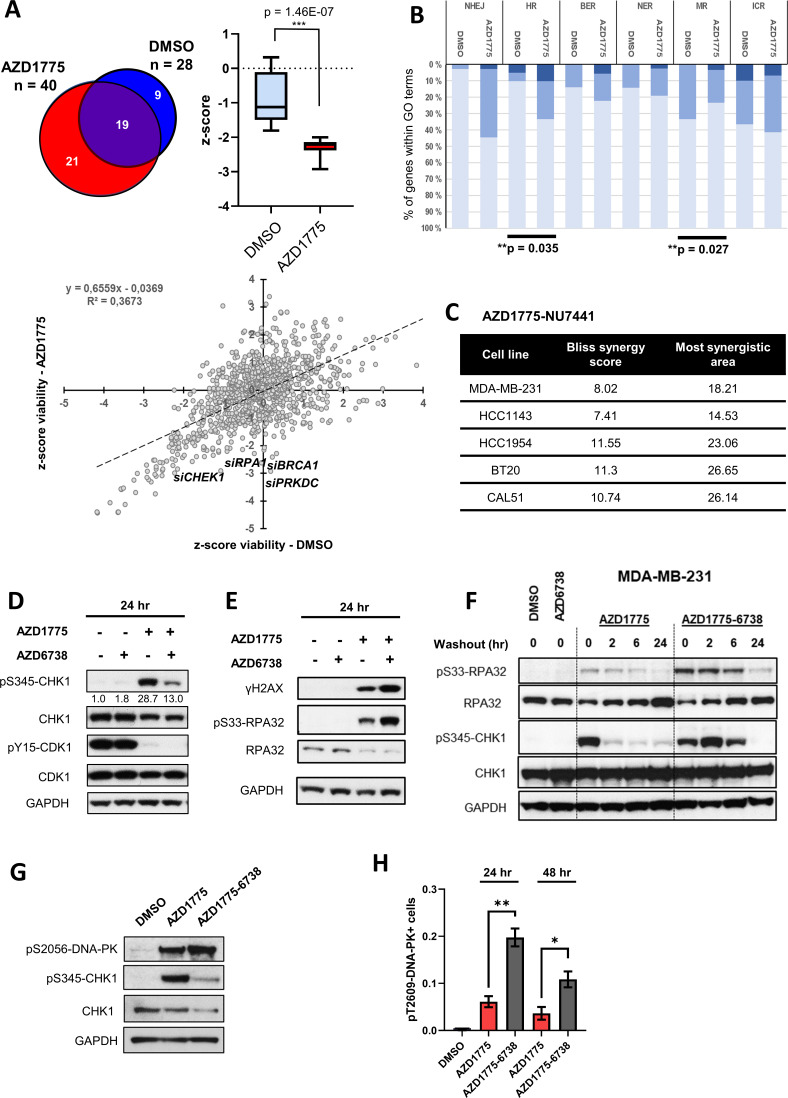
DNA-PK is phosphorylated in response to AZD1775 and preserves CHK1 phosphorylation independent of ATR.(A) MDA-MB-231 cells were transfected with a library of siRNAs targeting 300 DNA repair genes and analysed for siRNA hits (three siRNAs per gene) reducing viability in response to AZD1775 treatment by high-content image analysis. siRNAs targeting 28 genes resulted in significant loss of viability in control conditions compared to 40 genes in combination with AZD1775. 21 genes selectively reduced viability when combined with AZD1775 (p=1.46E-7) (Upper panel). Scatter plot visualisation of the viability z-score correlation of all siRNAs in the screen. Target genes (siRNAs) affecting MDA-MB-231 cell viability from the DDR siRNA library in response to 72 hr treatment of AZD1775 are marked in the plot (Lower panel). (B) Grouping of different DNA repair pathway-associated genes from high-content siRNA screen based on gene ontologies. Knockdown of homologous recombination (HR) genes associates with increased sensitivity to AZD1775 (p=0.035). Bars are coloured according to z-score. z-score < −2 (dark), z-score < −1 (medium) and z-score - n.s. (light). (C) BLBC cell lines were treated with NU7441 and AZD1775 at different concentrations for three days. Drug synergy scores (Bliss model) calculated from dose-response matrices are shown as indicated. (D) MDA-MB-231 cells were treated for 24 hr with the indicated drugs or DMSO control as specified. Whole cell lysates were collected, and expression and phosphorylation of CHK1 and CDK1 was analysed by immunoblotting with the specified antibodies. Expression of phosphorylated CHK1 was quantified by normalizing band density to total CHK1 band density. GAPDH level was used as loading control. (E) MDA-MB-231 cells were treated as in D and protein expression and phosphorylation analysed with the specified antibodies, as depicted. (F) MDA-MB-231 cells were treated as in D and harvested or allowed to recover in the absence of the compounds for 2, 6 or 24 hr before harvesting. Total cell lysates were immunoblotted with the indicated antibodies. (G) MDA-MB-231 cells treated for 24 hr with the indicated drugs and phosphorylation of DNA-PK (pS2056) and CHK1 (pS345) was assessed by immunoblotting. GAPDH level was used as loading control. (H) MDA-MB-231 cells were treated with the indicated drugs for 24 or 48 hr and phosphorylation of DNA-PK (pT2609) was analysed by high-content immunofluorescence microscopy. The proportion of pT2609-DNAPK-labelled cells represents mean of three biological replicates ± SEM. * and ** indicate p=0.029 and p=0.0036 respectively, as assessed by Student’s t-test.
Figure 4—source data 1.DNA-PK is phosphorylated in response to AZD1775 and preserves CHK1 phosphorylation independent of ATR.(B) Grouping of different DNA repair pathway-associated genes from high-content siRNA screen based on gene ontologies. (C) Viability matrix based on alamarBlue staining to assess synergy between AZD1775 and NU7441 in MDA-MB-231, HCC1143, HCC1954, BT20 and Cal51 cells. (H) MDA-MB-231 cells were treated with the indicated drugs for 24 or 48 hr and phosphorylation of DNA-PK (pT2609) analysed by high-content immunofluorescence microscopy. The proportions of pT2609-DNAPK-labelled cells are shown.